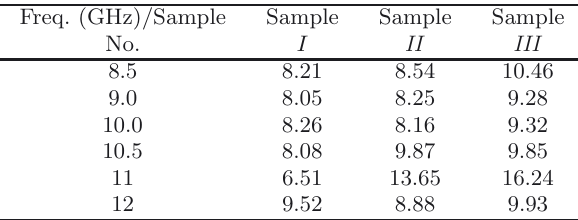
Table 3. SE values in dB of three textile samples. Freq. (GHz)/Sample Sample Sample